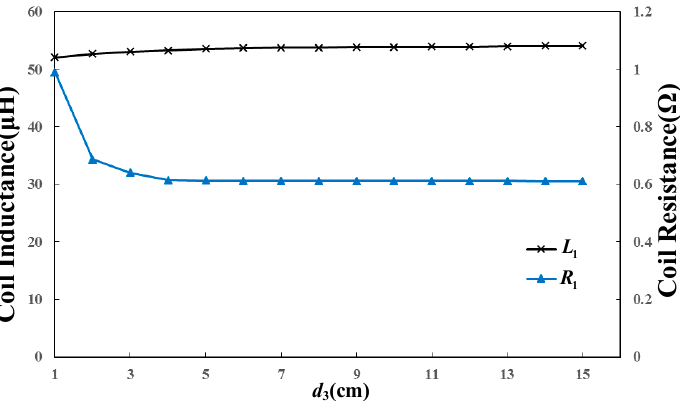
Figure 7. Inductance and resistance of the coil versus the distance when the iron metal object is placed along the line l 3 .